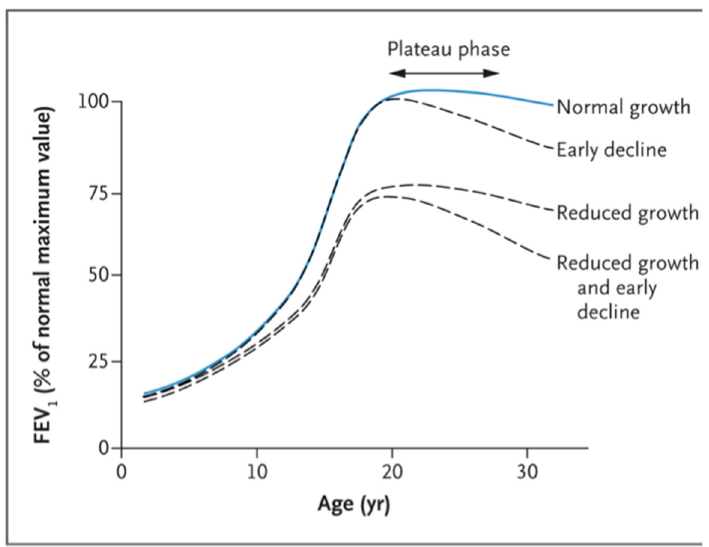
Figure 3. Longitudinal lung-function trajectories reproduced with permission from McGeachie et al. [70]. et al.